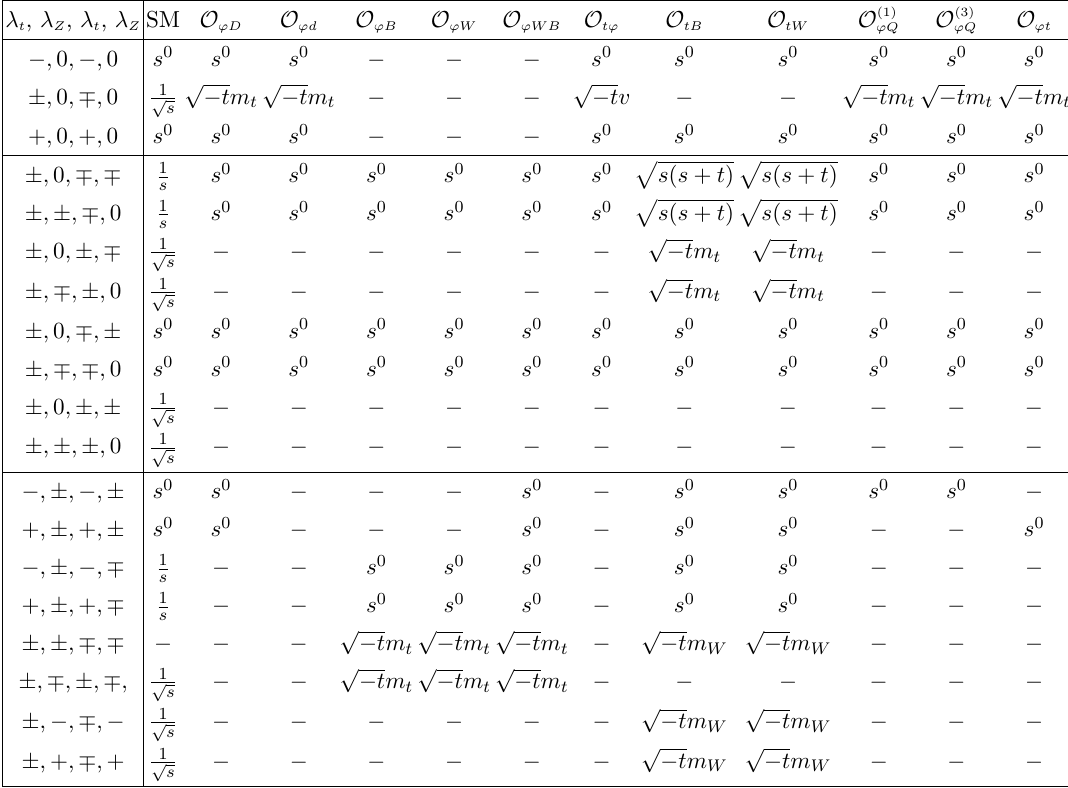
Table 14. Helicity amplitudes in the high-energy limit ( s Overall multiplicative factors are dropped and only the schematic energy dependence is retained for the SM contribution. Helicity entries marked by ‘ section 5.1.4 for a discussion of the